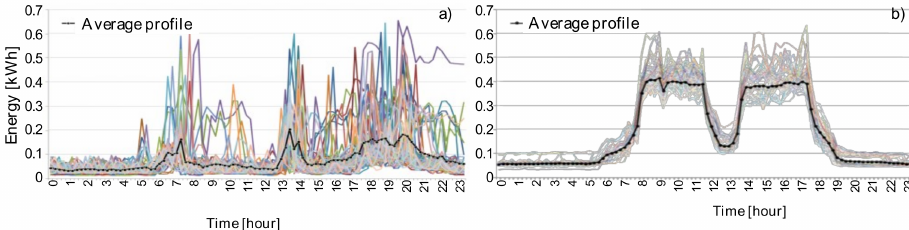
Figure 3. Example of the consumption patterns during the winter weekdays of ( a ) a residential (main residence) customer and ( b ) an industrial